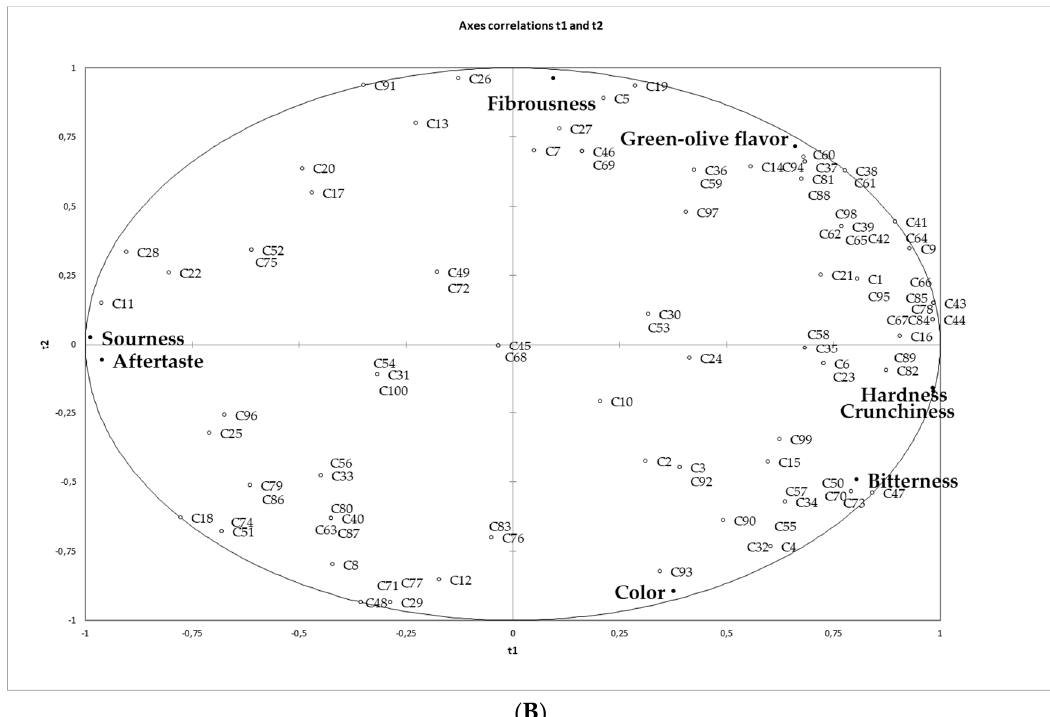
Figure 2. Partial least squares regression (PLS) of (A) volatile compounds (chemical families sum) (X axis: t2) and overall consumer liking (Y axis: t1) (unfiled circles: consumer (C + number of consumer); filled circle: volatile compound); and, (B) descriptive sensory attributes (X axis) and overall consumer liking (Y axis) (unfiled circles: consumer (C + number of consumer; filled circle: descriptor).